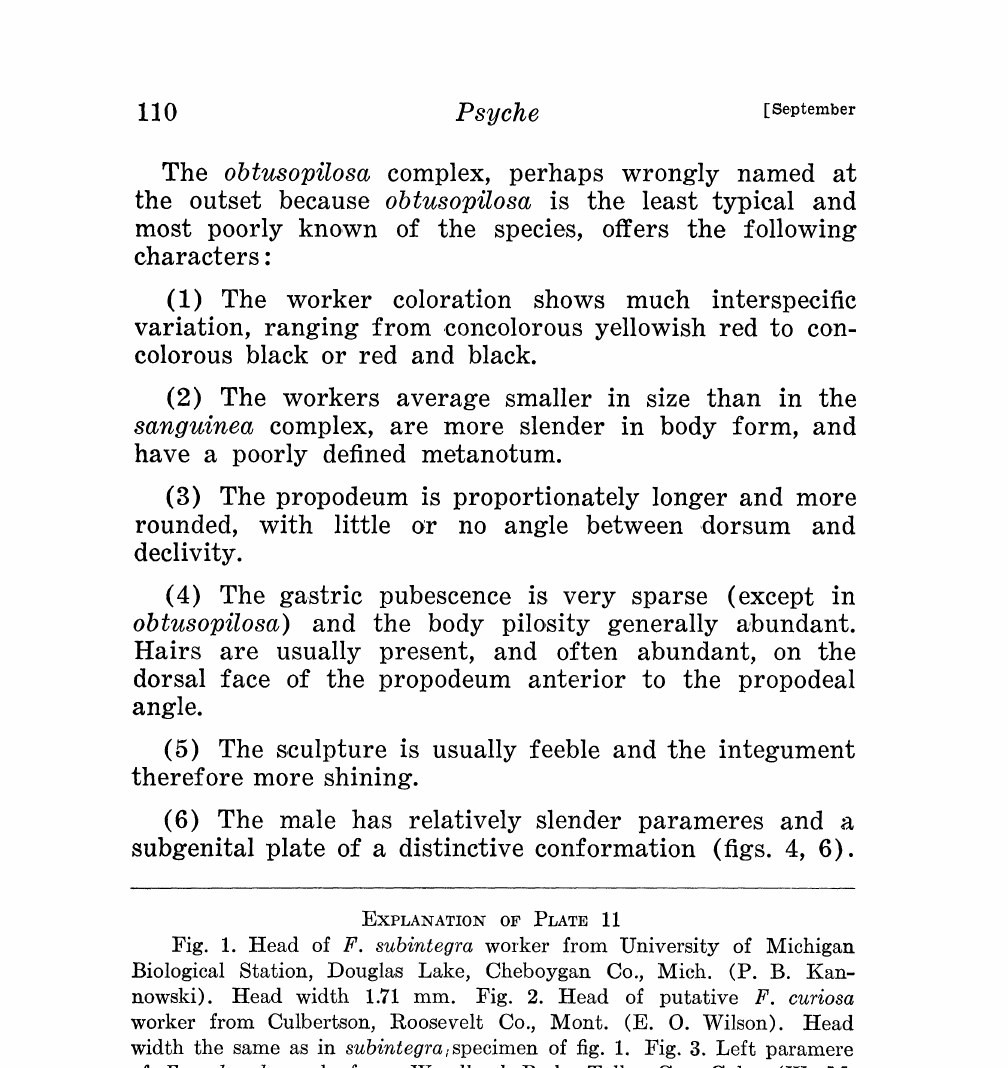
Fig. 1. Head of F. subintegra worker from University of Michigan Biological Station, Douglas Lake, Cheboygan Co., Mich. (P. B. Kan- aowski). Head width 1.71 mm. Fig. 2. Head of putative F. curiosa worker from Culbertson, Roosevelt Co., Mont. (E. O. Wilson). Head width the same as in subintegralspecimen of fig. 1. Fig. 3. Left paramere ,of F. subnuda male from Woodland Park, Teller Co., Colo. (W. M. Wheeler). Fig. 4. Left paramere of F. perpilosa male from Ft. Davis, Texas (W. M. Wheeler). Fig. 5. Posterior border of subgenital plate of same specimen as in fig. 3 (F. subnuda). Fig. 6. Posterior border of subgenital plate of same specimen as in fig. 4 (F. perpilosa). Fig. 7. Left side view of petiole of F. subintegra worker trom Rogers City, Presque Isle Co., Mich. (P. B. Kannowski). Head width 1.63 mm. Fig. 8. Left side view of petiole of F. subnuda worker from Kiowa, Glacier Co., Mont. (E. O. Wilson). Head width 1.76